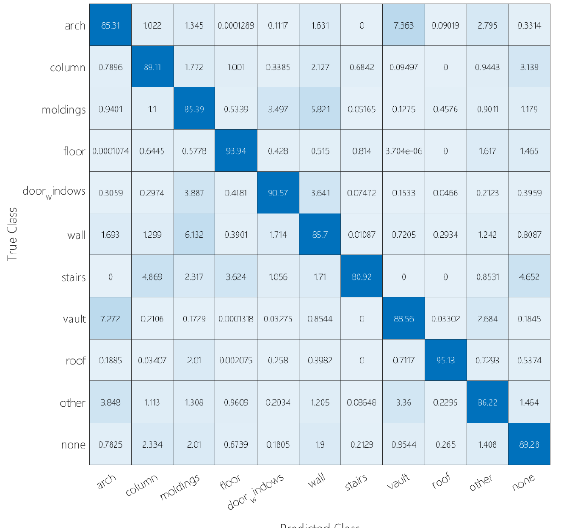
Figure 4: Confusion Matrix for Test 2.